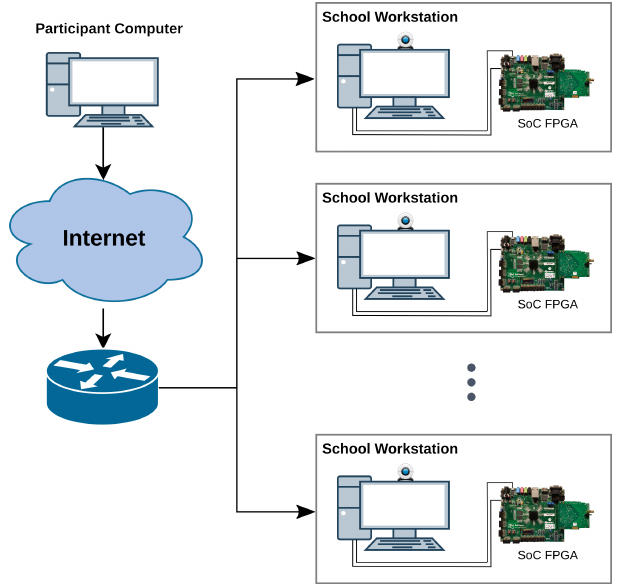
Figure 2. Overview of the remote laboratory